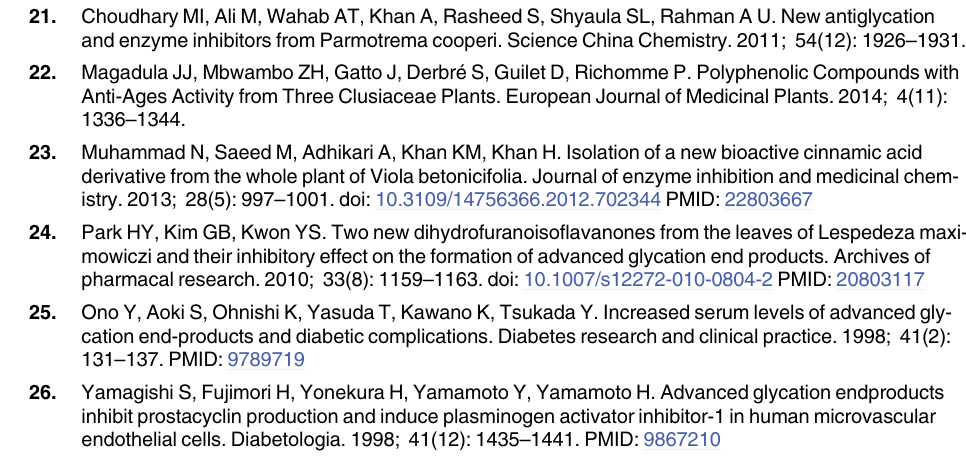
PLOS ONE | DOI:10.1371/journal.pone.0131222 June 25,